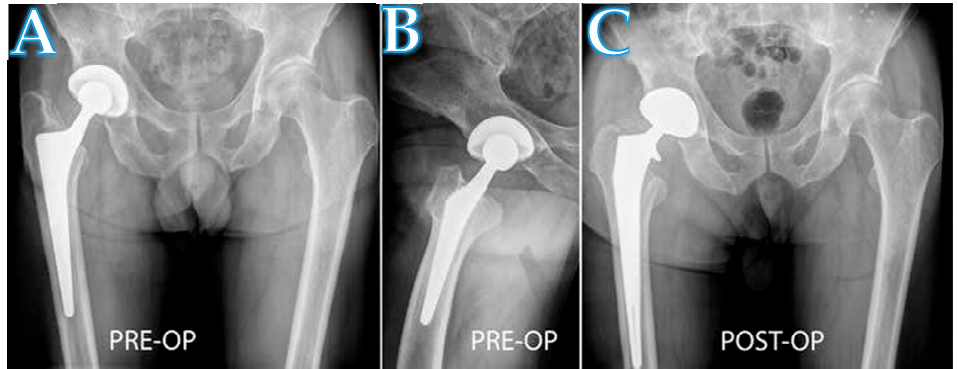
Figure 4. A radiograph showing a patient with aseptic loosening of a femoral stem in the right hip ( A , B ). The implantation of the long revision stem was performed with a proximal extension of the DAA ( C ) .